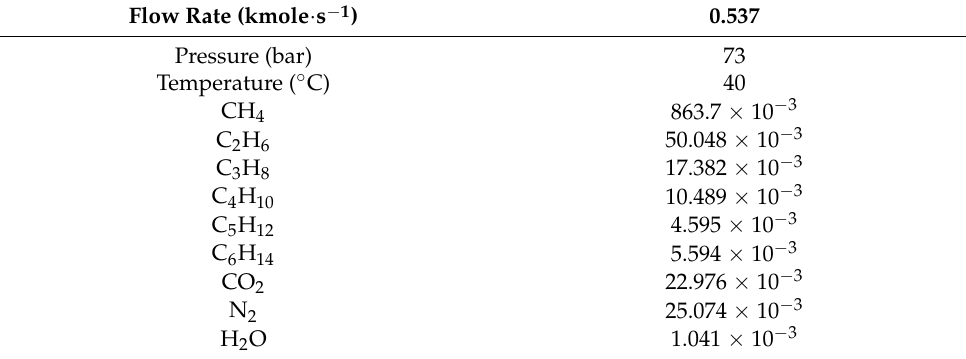
Table 2. Composition and specifications of the feed.